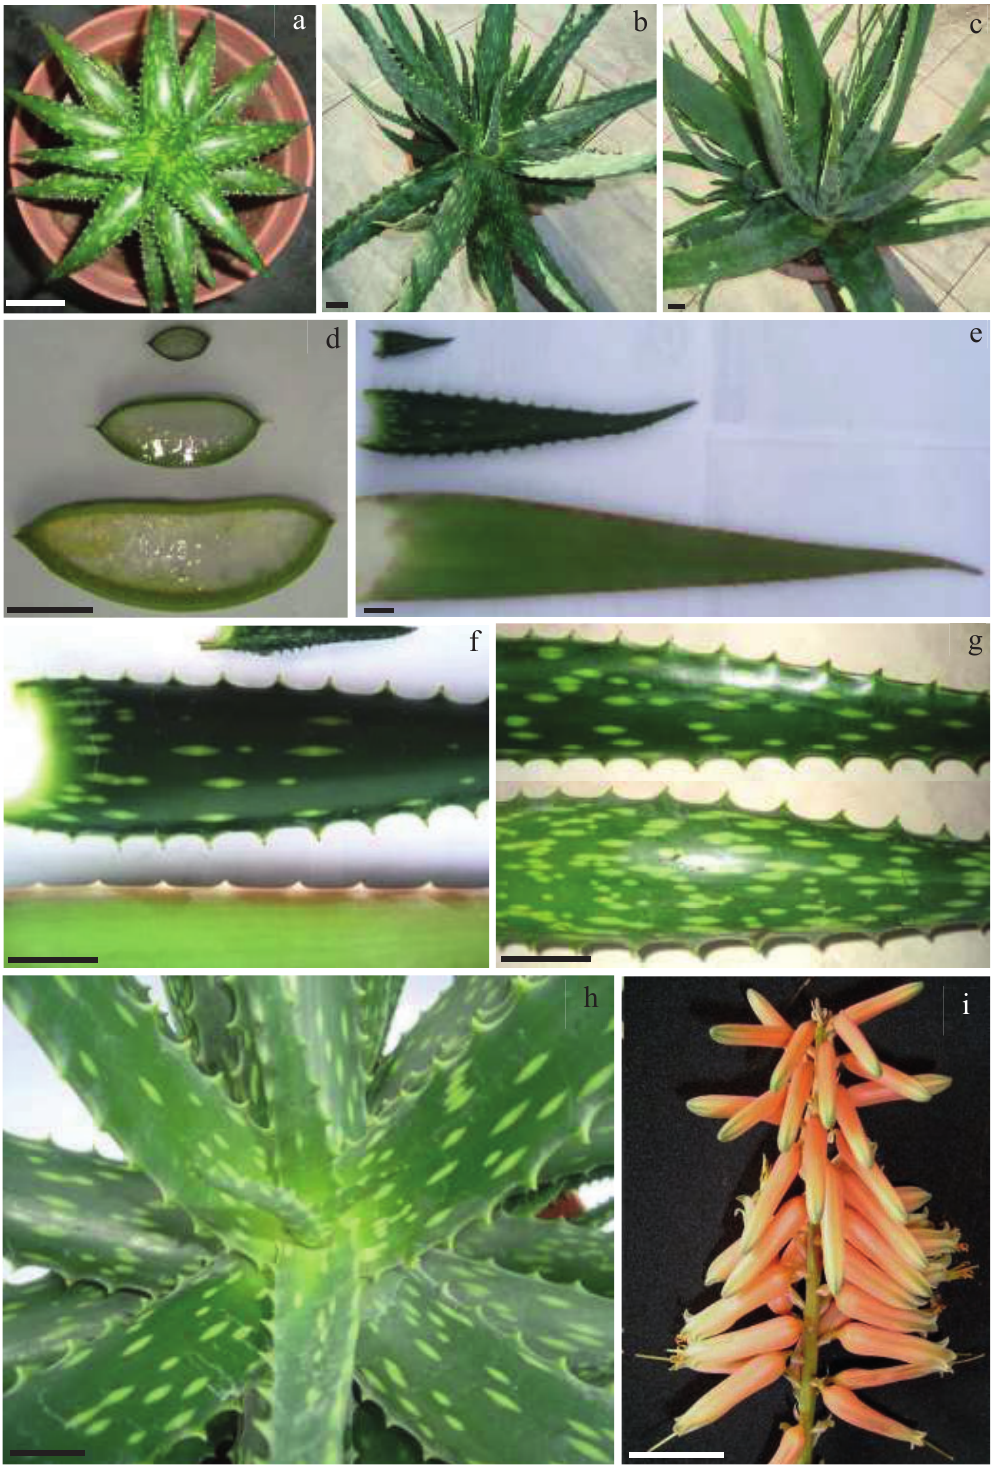
Figure 1. Vegetative traits of the hybrid and its parents. (a) Aloe jucunda , (b) hybrid, (c) A. vera , (d) cross section in leaves of A. jucunda (upper), hybrid (middle), and A. vera (lower), (e) leaf lengths in the three genotypes, (f) contrasting details in the colour of the leaves, spots, and foliar teeth of the three genotypes evaluated, g) diff erences in the number of leaf spots between the adaxial face and the abaxial face in the leaves of the experimental hybrid, vegetative (h) and fl oral (i) details of the experimental hybrid. Scale bars = 2